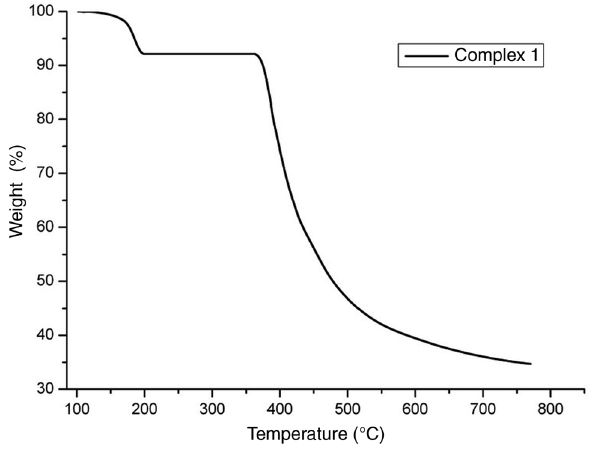
Figure 4: TG curve of the complex.